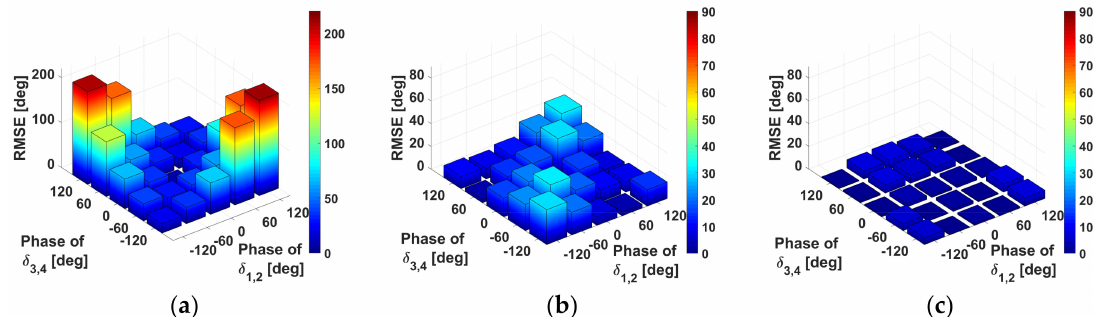
Figure 2. RMSE of cross-talk estimates for cross-talk phase variability using simulation data obtained by ( a ) the Van Zyl method, ( b ) the Quegan method and ( c ) the Villa method.